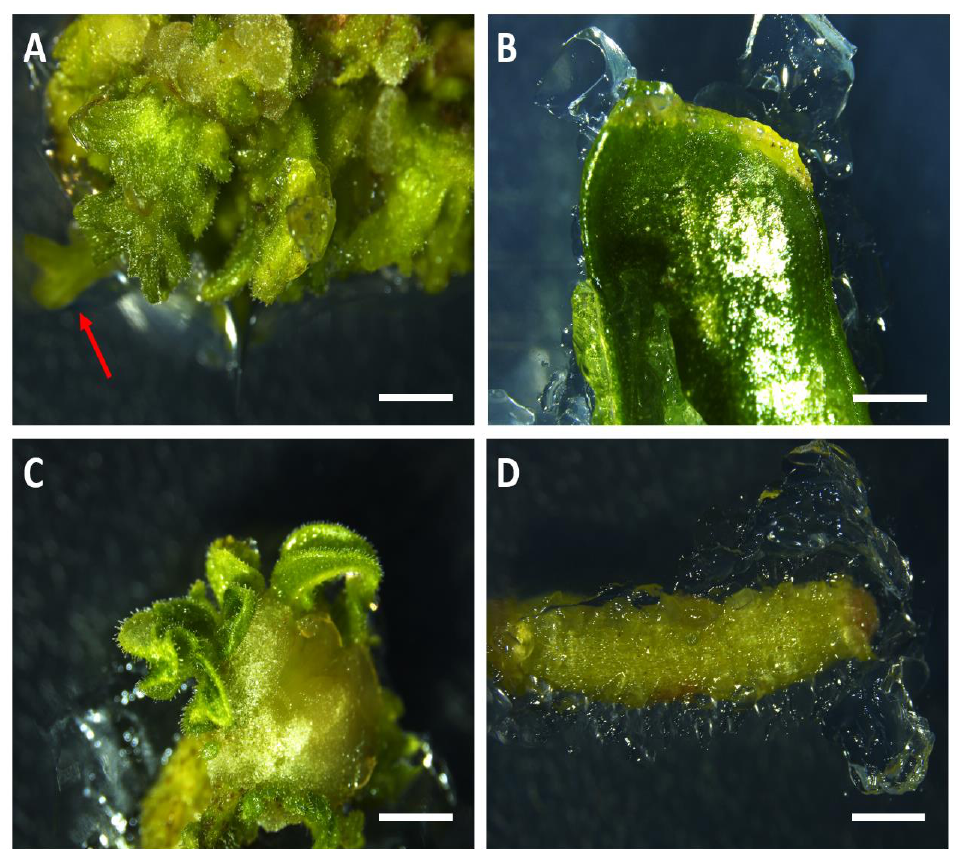
a For each factor, means separated by different letters are significantly different at p <0.05 according to the non-parametric pairwise Wilcoxon test.